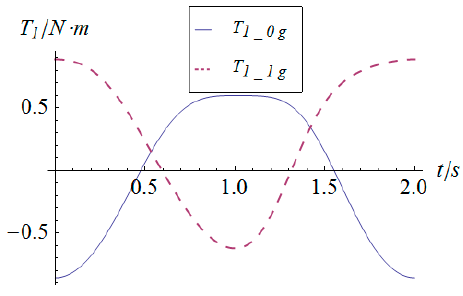
Figure 16. Torque vs. time of actuator 1.